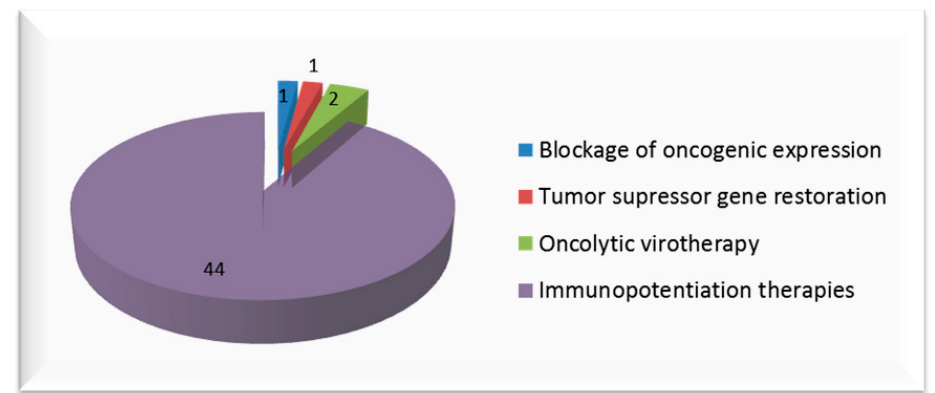
Figure 4. Number of ongoing or completed clinical trials in gene targeted therapy for cervical cancer worldwide from 1989 to 2018. They are grouped by the strategy used according to The Journal of Gene Medicine Clinical Trial site (source: http://www.abedia.com/wiley/indications.php) [127].